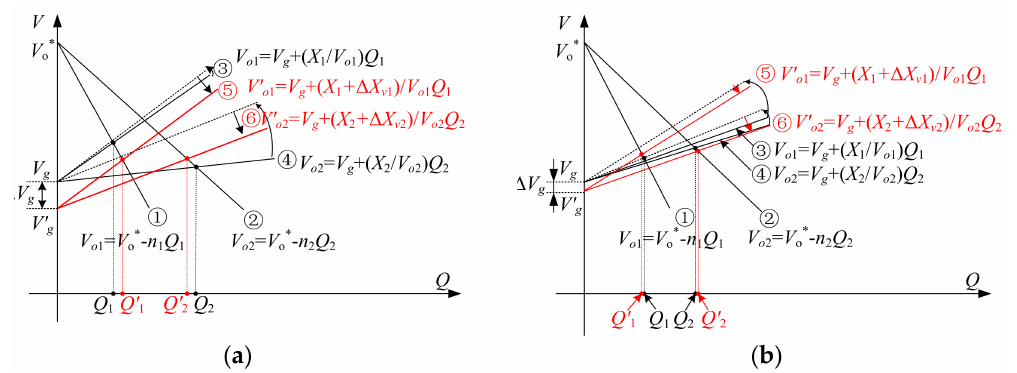
Figure 3. Equivalent circuit of two inverters operated in parallel (one phase) Reactive power regulating process with proposed control method. ( a ) Case 1: ( X 1 / X 2 ) > 2; ( b ) Case 2: ( X 1 / X 2 ) <